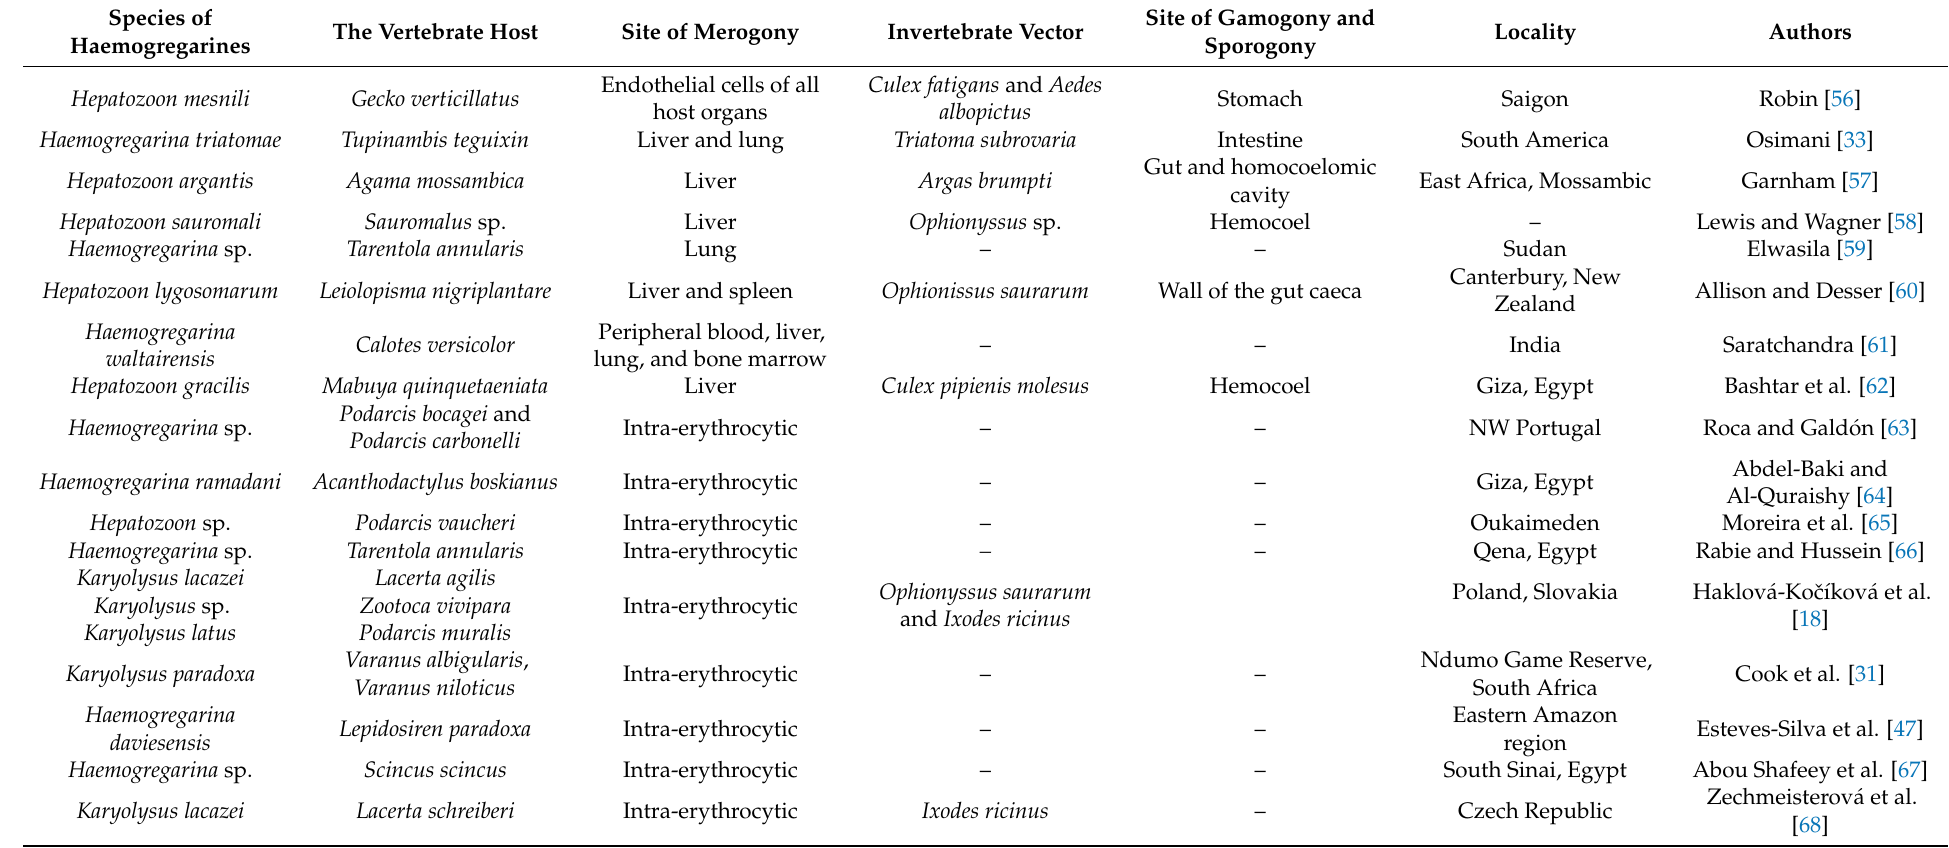
Table 4. Haemogregarines of